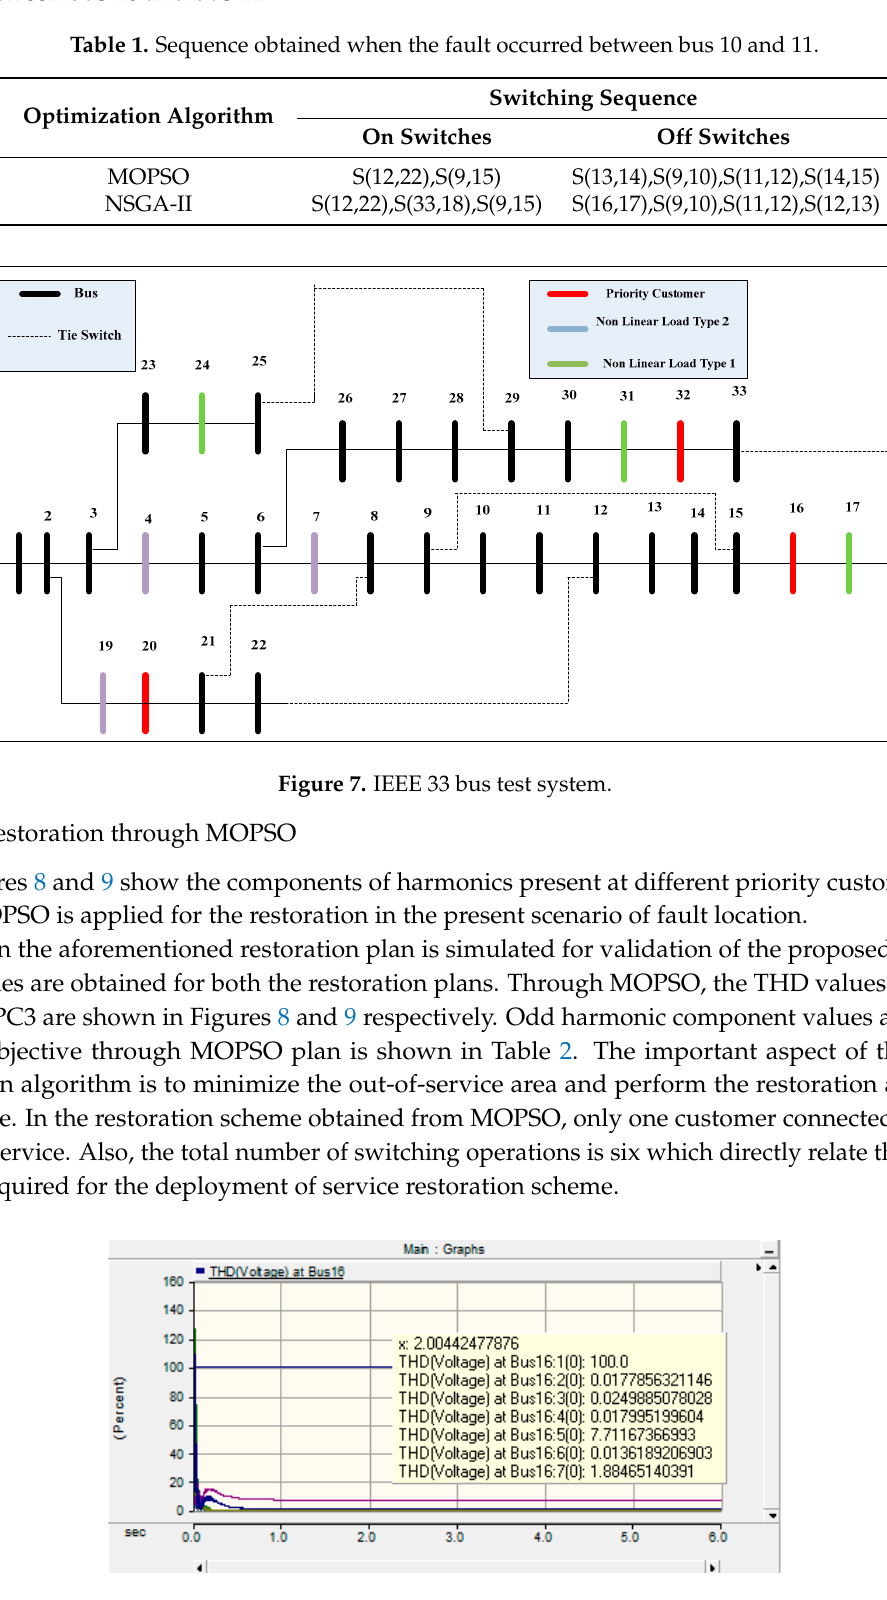
Figure 8. The harmonic components at the point of common coupling of the priority customer connected to bus no.16. THD: Total Harmonic Distortion.